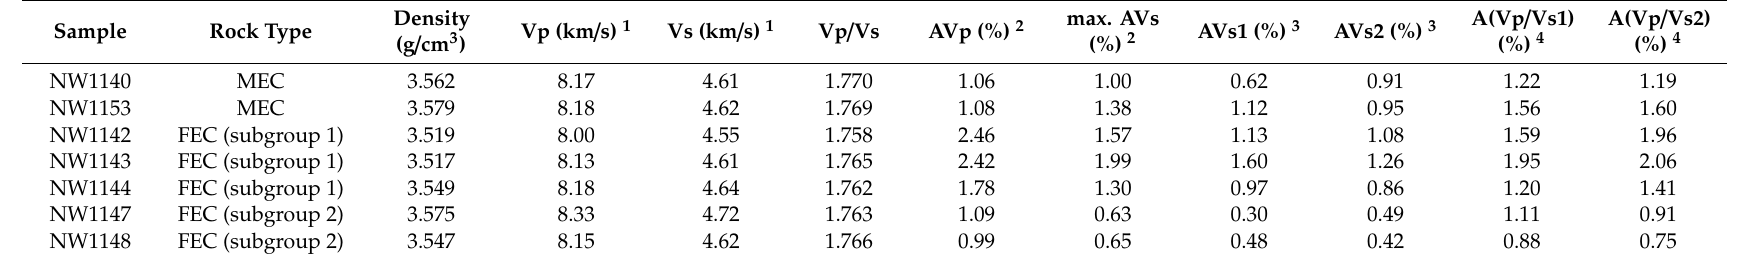
Table 2. Calculated seismic properties of the studied MEC and FEC